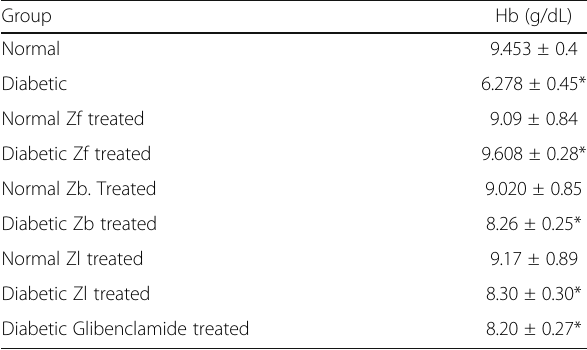
Data represented as mean±S.D. values of 6 animals each * p <0.001 (One way ANOVA, Dunnet ’ s t-test, Graph pad prism software). Normal control was compared with normal control and extract treated. The Diabetic control was compared with diabetic extract treated and standard